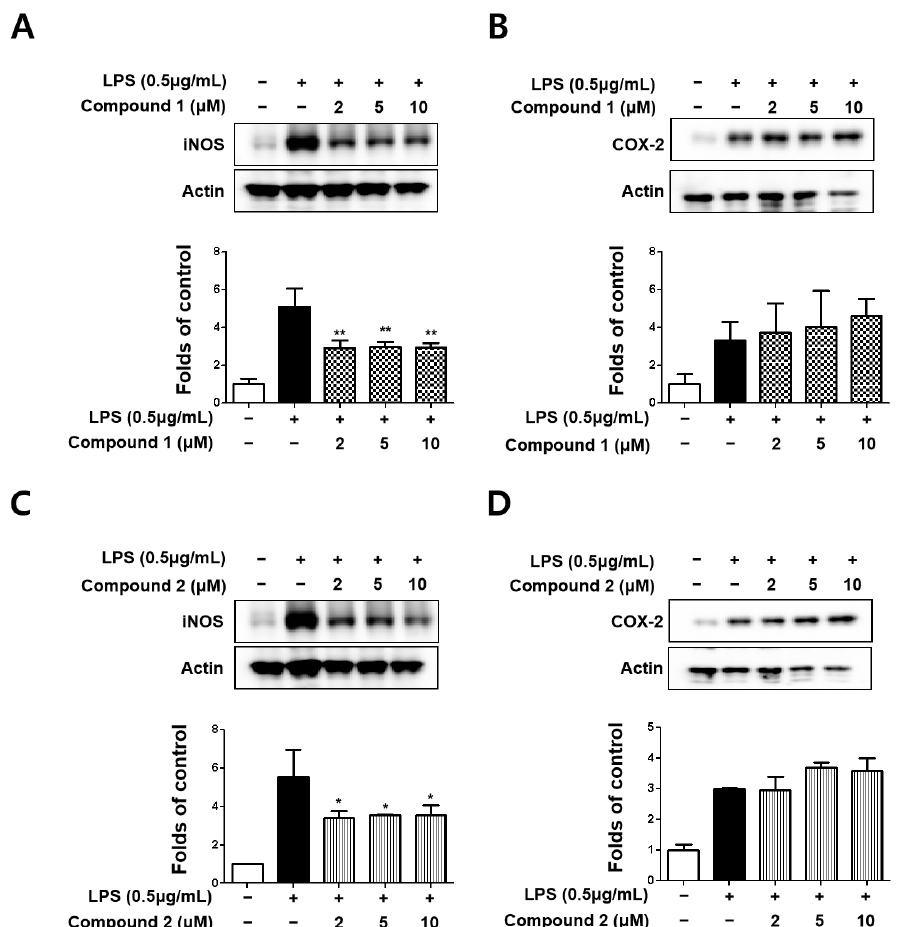
Figure 3. Protein expression levels of inducible nitric oxide synthase (iNOS) ( A , C ) and cyclooxygenase-2 (COX-2) ( B , D ) in lipopolysaccharide (LPS)-stimulated BV2 cells. Cells were pretreated for 3 h with indicated concentrations of compounds 1 and 2 and stimulated for 24 h with LPS (0.5 μg/mL). Representative blots from three independent experiments are shown. Immunoblots were quantified using ImageJ software. Band intensities were normalized to β -actin. * p < 0.05, ** p < 0.01 compared with LPS-treated group.